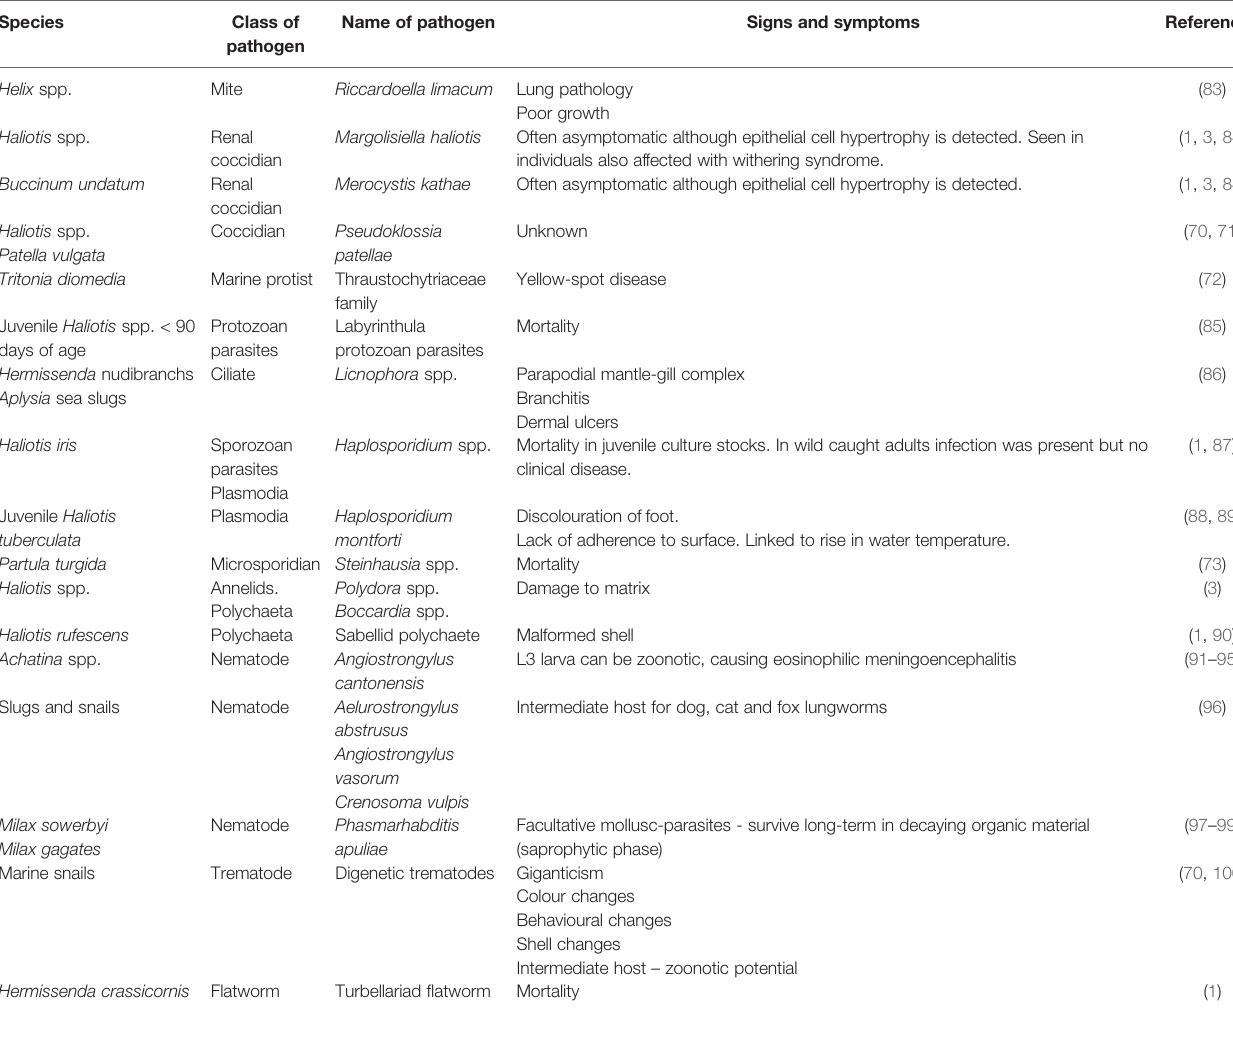
TABLE 2 | Parasitic diseases of